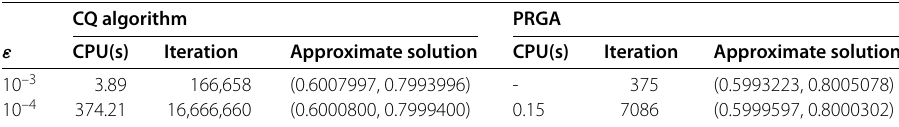
Table 3 Numerical results for Example 5.1 ( x 1 = (1,1) T , ρ n = ρ = 0.06 for all n ∈ N )